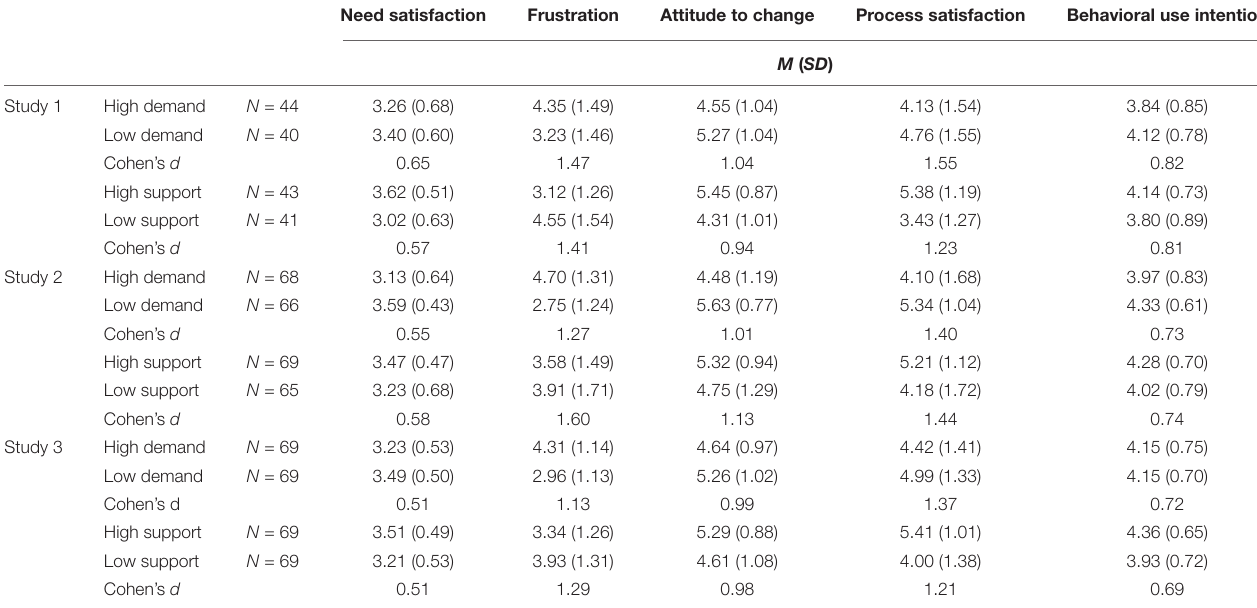
TABLE 1 | Means and standard deviations of study